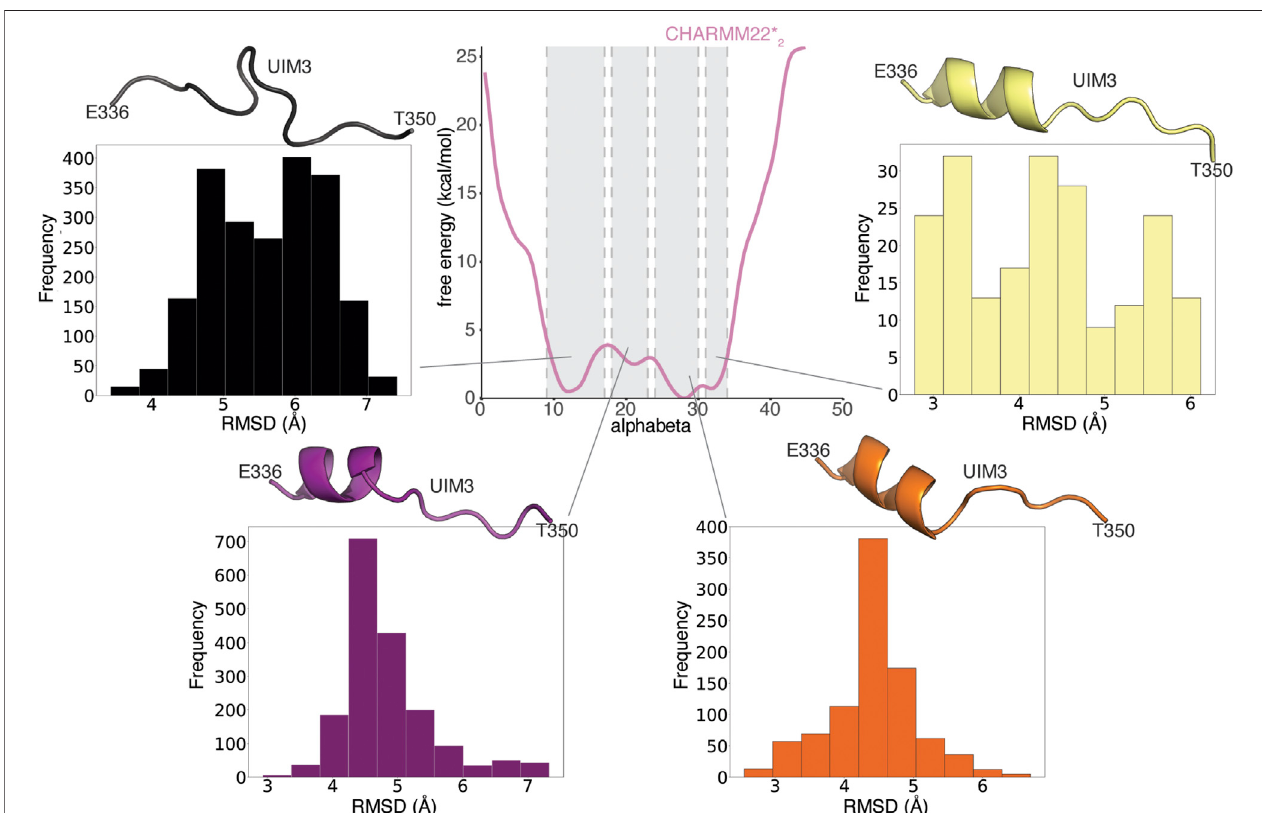
FIGURE 5 | UIM3 of AT-3 306-361 interconverts between disordered conformations and partially helical states in the free ensemble. The central panel shows the mono-dimensionalfreeenergypro fi leassociatedwithalphabetaforCHARMM22* 2 (pink)metadynamicssimulation.ThefoursidepanelsshowtheRMSDcalculationsof UIM3 structures from the CHARMM22* 2 metadynamics trajectory, using as a reference the starting structure of AT-3 306-361 for the REMD simulations, in which UIM3 is modeled as an α -helix. We used the C β atom of A343 and the backbone (C α , C, O, N) atoms of the residues E336-T350 of UIM3 for rigid body superposition and theRMSDcalculation.WecalculatedtheRMSDoffourensemblesofstructuresofUIM3withalphabetavaluesintherangesof:i)9 – 17(black),ii)18 – 23(purple),iii)24 – 30 (red),andiv)31 – 34(yellow),respectively.ThecartoonrepresentationsshowthestructuresofUIM3withthelowestRMSDineachofthefoursubsets.Weidentifypartially helical states of UIM3 associated with alphabeta values in the range of 24-30 and 31 –